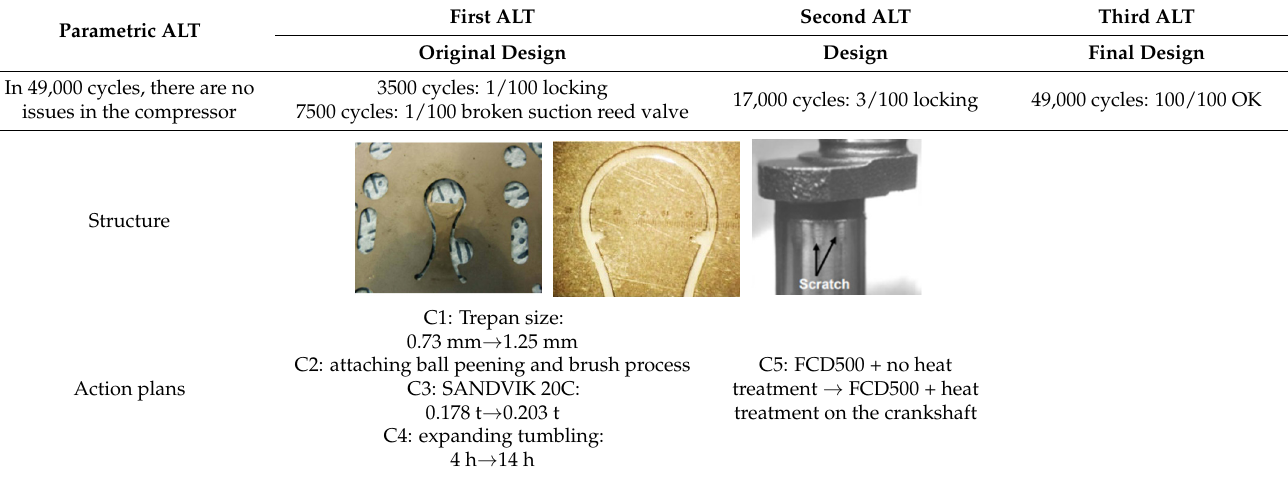
Table 4. Compressor ALT outcomes.